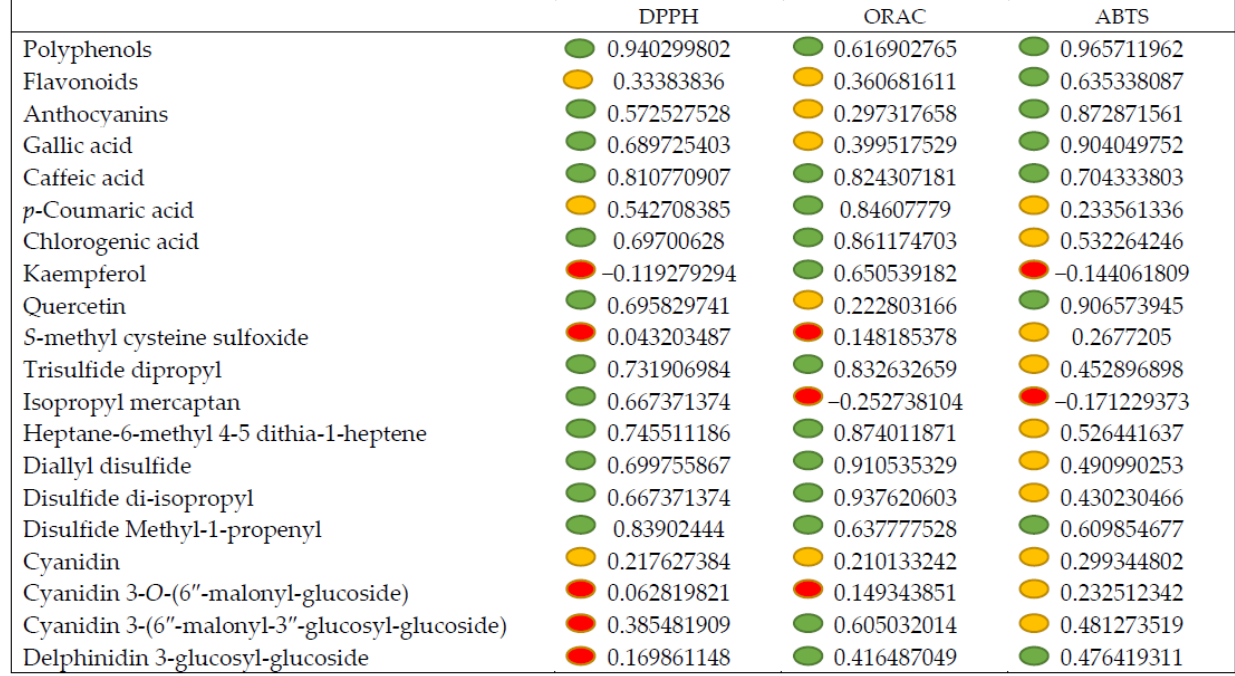
7 of 21 Figure 3. Antioxidant activities (ORAC, DPPH and ABTS) detected in red onion bulbs differently fertilized: control (CTR), sulphur bentonite (SB), sulphur bentonite-low percentage orange residue (SBOR LP), sulphur bentonite-high percentage orange residue (SBOR HP), and sulphur bentonite- olive pomace (SBOP). Data are the mean of three replicates. Pearson’s correlation (Figure 4) evidenced that the total phenols were positively and significantly correlated with ABTS (r = 0.96), DPPH (r = 0.57), and ORAC (r = 0.62); the flavonoids correlated only with ABTS (r = 0.63), while the anthocyanins correlated with DPPH (r = 0.57) and ORAC (r = 0.87). Among the single phenolic acids, caffeic acid corre-